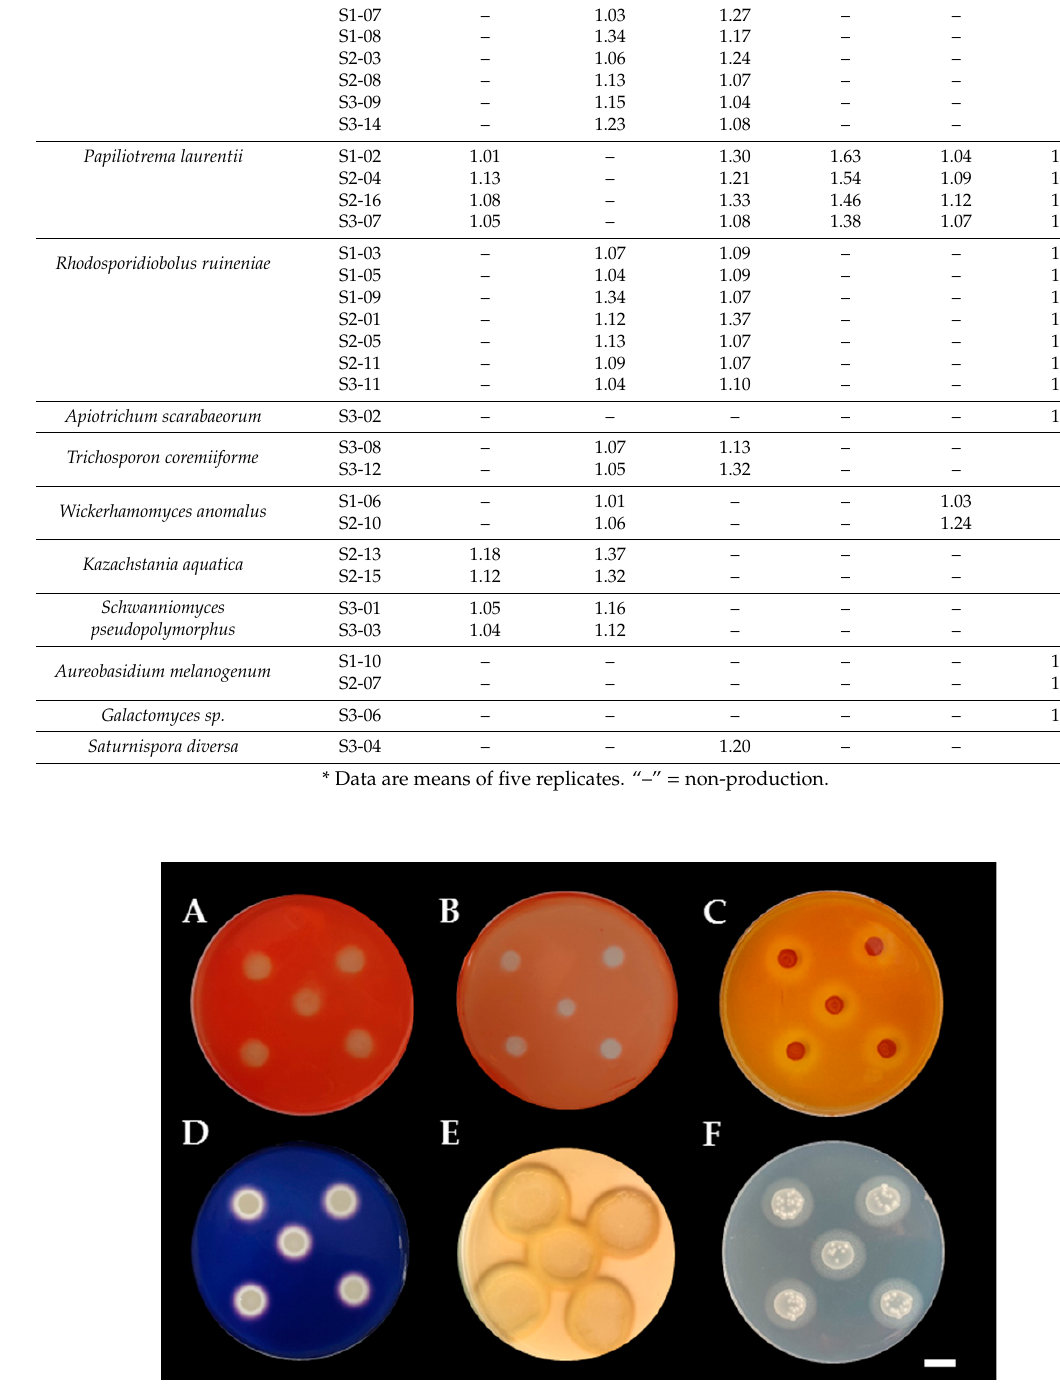
Figure 5. ( A − F ); Screening of extracellular enzyme production, endoglucanase production by T. asahii SDBR-CMU-S1-01 ( A ), xylanase production by P. laurentii SDBR-CMU-S1-02 ( B ), pectinase production by P. laurentii SDBR-CMU-S1-02 ( C ), amylase production by P. laurentii SDBR-CMU-S2-04 ( D ), protease production by W. anomalus SDBR-CMU-S2-10 ( E ) and lipase production by T. asahii SDBR-CMU-S1-07 (F). Scale bar = 10 mm.